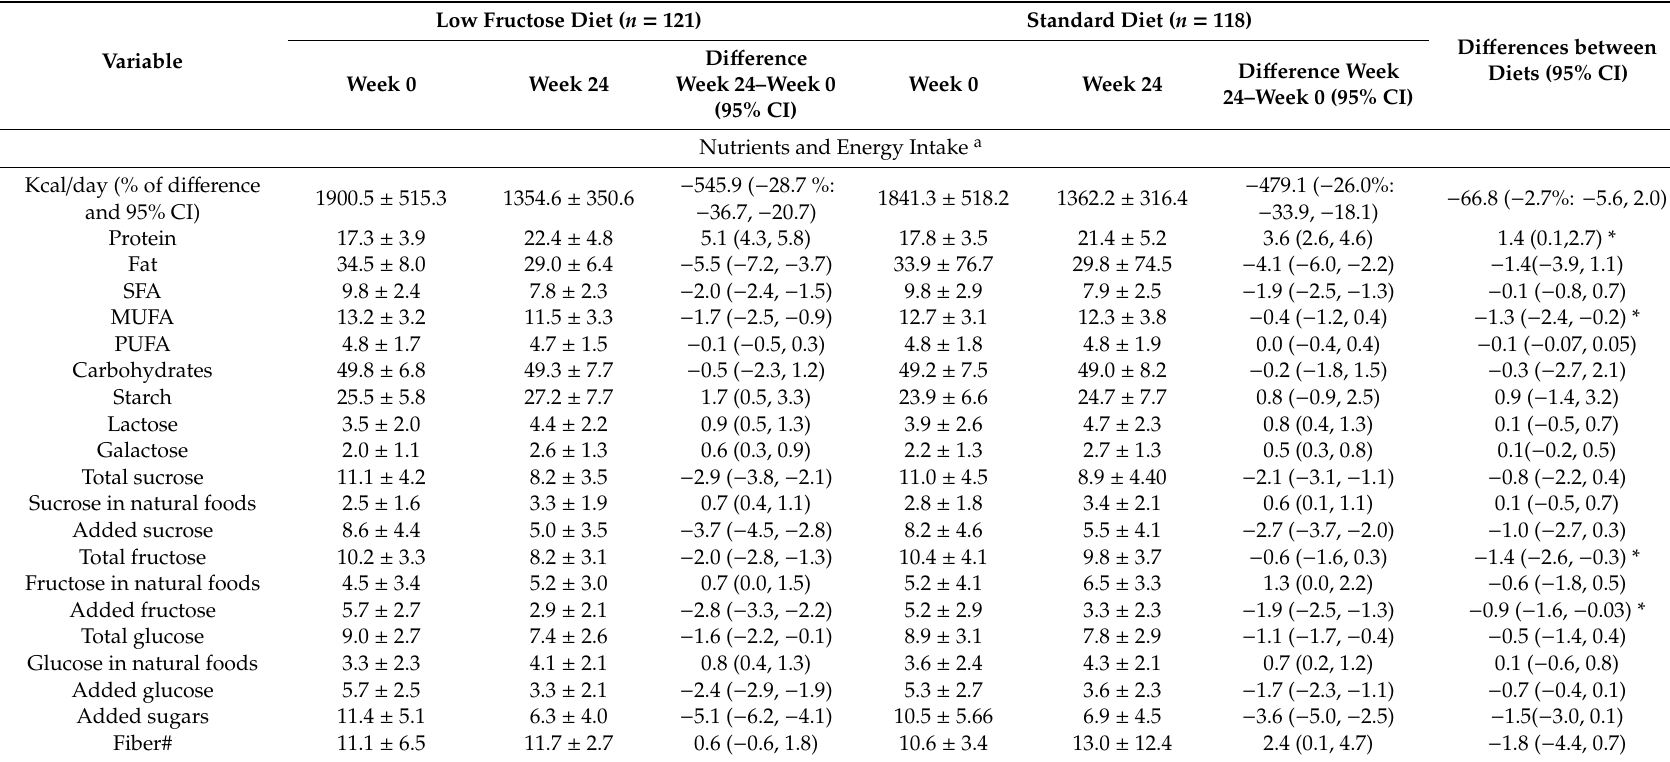
Table 3. Di ff erences in energy intake, nutrients (% energy), anthropometric variables, blood pressure, biochemical values, and leisure time physical activity between week 24 and week 0 within and between